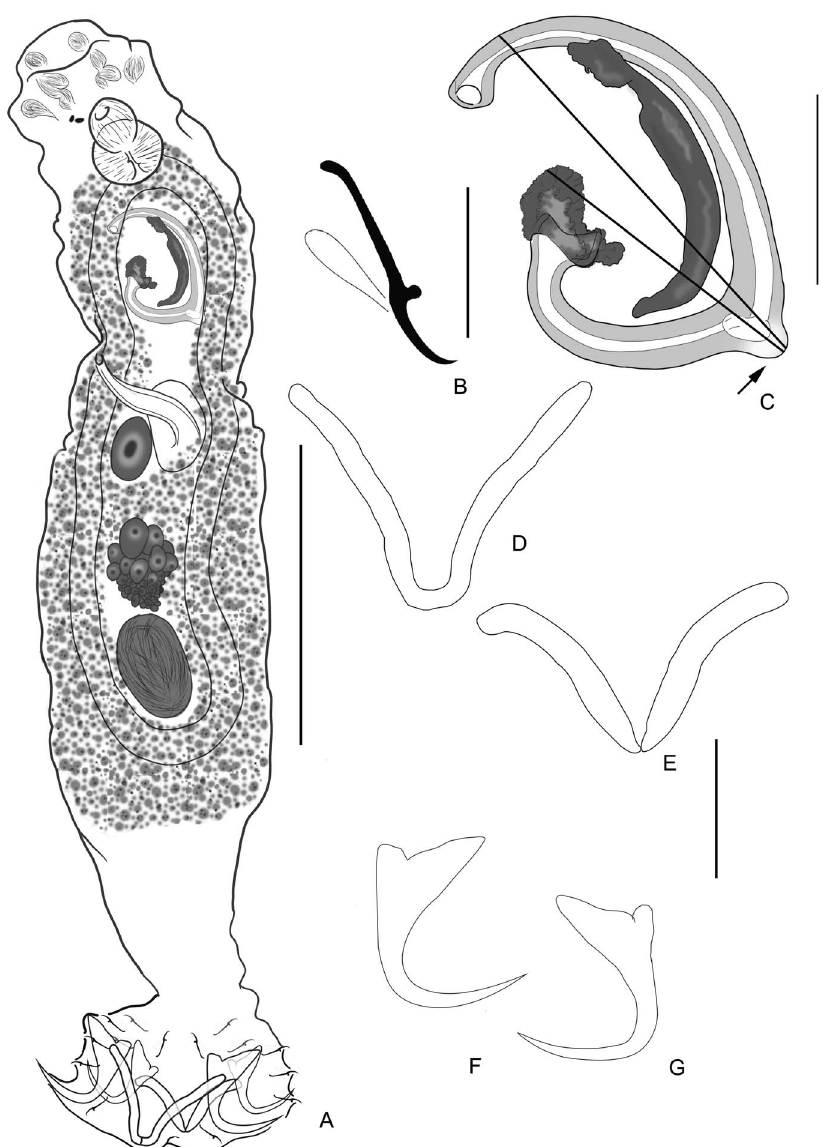
Figure 5. Demidospermus tocantinensis n. sp. from Auchenipterus nuchalis . (A) Total, ventral view; (B) Hook; (C) Copulatory complex, knee-like expansion of the male copulatory organ (arrow), ventral view; (D) Ventral bar; (E) Dorsal bar; (F) Ventral anchor; (G) Dorsal anchor. Scale bars: (A) 100 l m; (B) 10 l m; (C) 30 l m; (D – G) 20 l